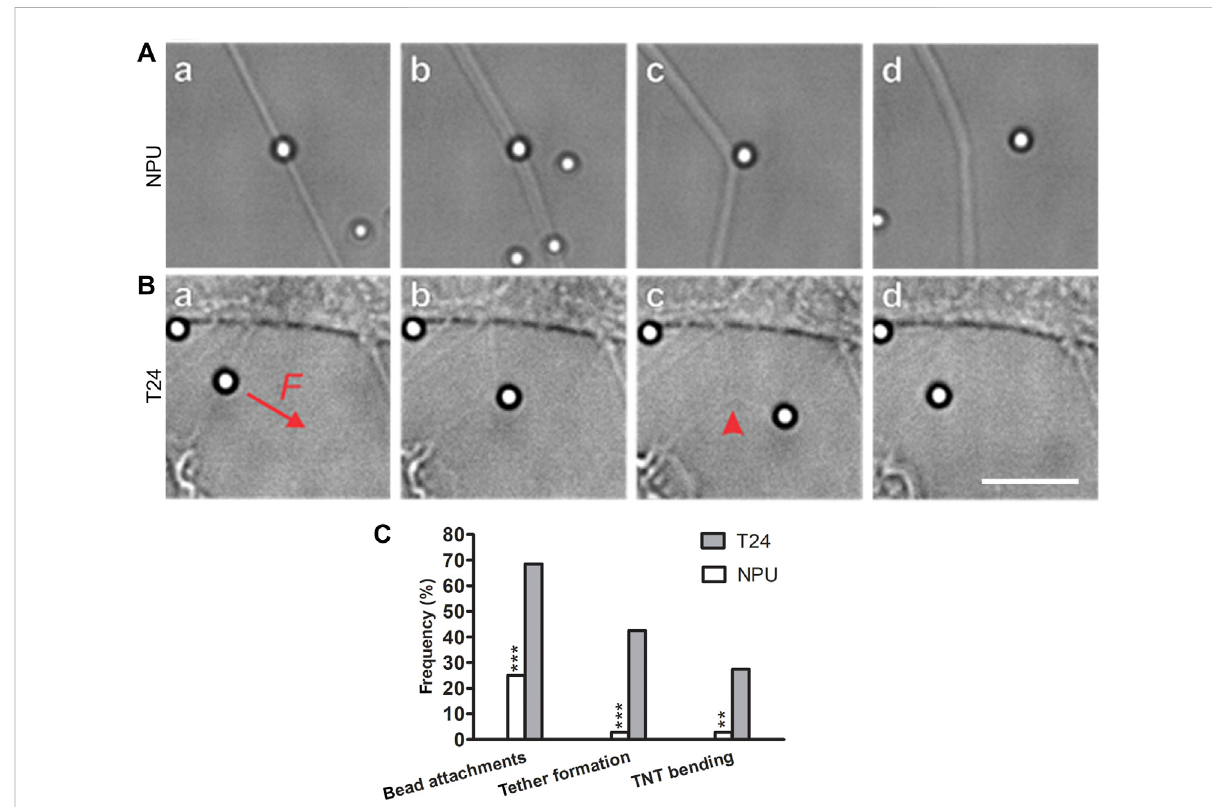
FIGURE 4 Elastic properties of TNTs in normal (NPU) and cancer (T24) urothelial cells. (A) An example of pulling a TNT of NPU cell (a, b, c). The TNT is less tense and remains bent even after the force subsides, when the microbead detaches (d). (B) A representative example of pulling a T24 cell TNT. A microbead is attached to a TNT and pulled perpendicular to the TNT (a, red arrow). The TNT bends into a tensed membrane tube with a sharp apex (b). A tether is pulled out of the TNT forming a Y-bifurcation (red arrowhead, c). After the force subsides, the TNT retracts to its initial state (d). The full sequences are available in Supplementary Videos S1, S2. Scale bar is 10 μ m. (C) The frequencies with which the microbeads attached to the TNTs, the tether formation directly from the TNTs, and the TNT bending capability. The beads were successfully attached to 25% of NPU cells and 68% of T24 cells. The tethers were more frequently formed from the TNTs of the T24 cells (42%) than from NPU cells (3%). In addition, 3% of TNTs in NPU cells and 27.4% in T24 cells were capable of bending. F denotes force exerted by the tweezers (~110 pN). NPU cells: n = 72 TNTs, T24 cells: n = 72 TNTs. ** p < 0.01, *** p <